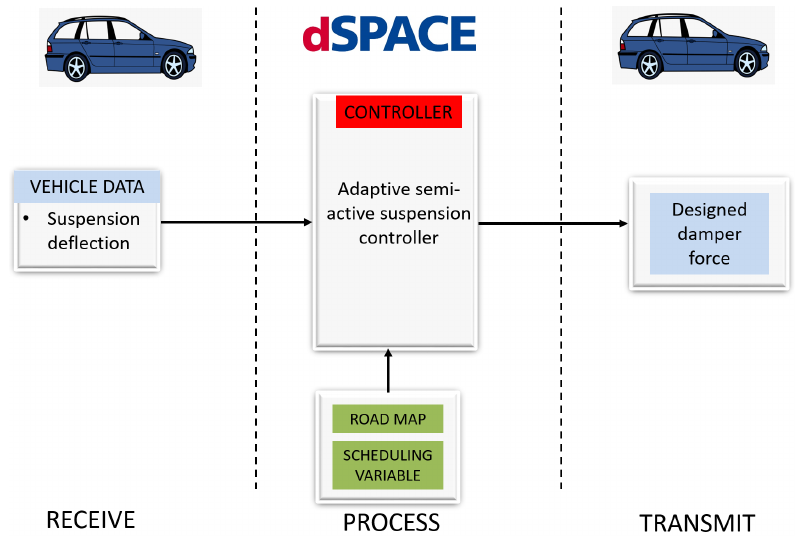
Figure 19. Real-time